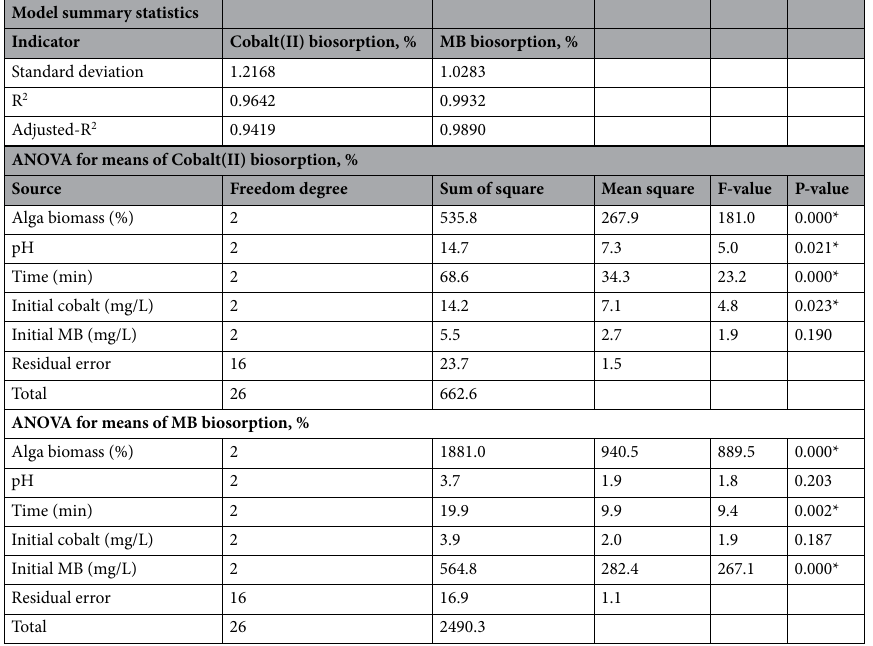
Table 2. Model summary statistics and ANOVA of both Cobalt(II) and MB biosorption, using the biomass of Sargassum latifolium as affected by the tested factors. R 2 is the coefficient of determination, * indicates a significant